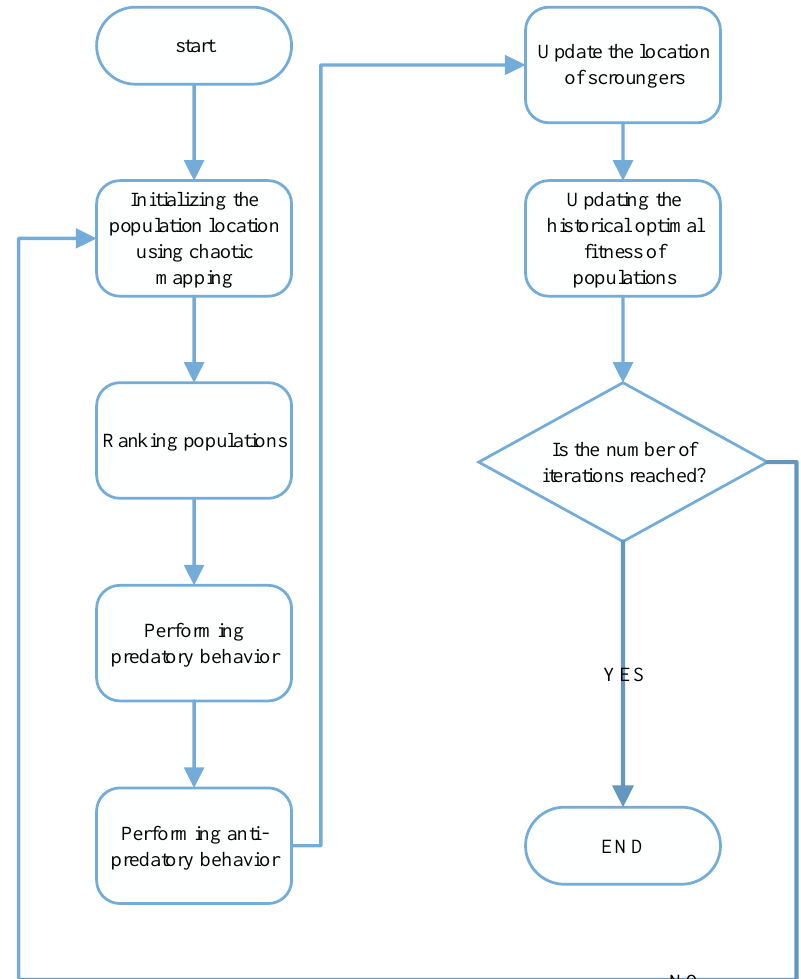
Figure 5. Chaotic mapping algorithm flowchart.